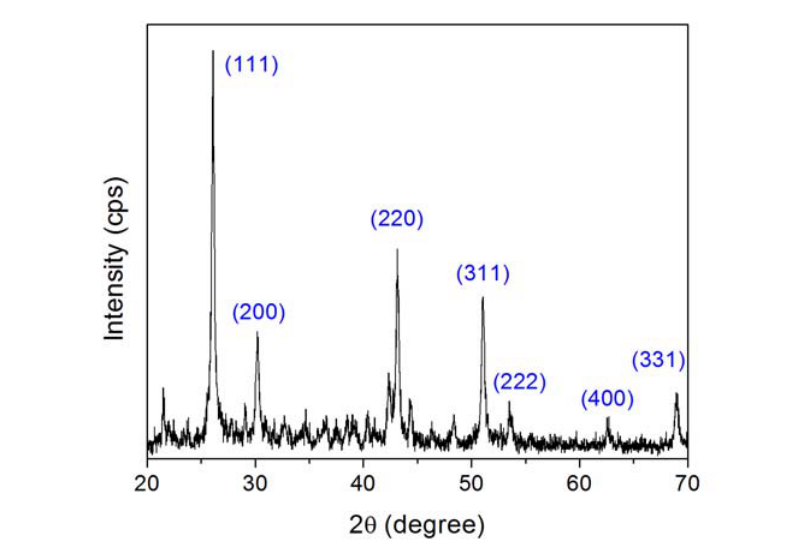
Figure 1. XRD results revealing the structure of PbF JCPDF file 06-0251. Major diffraction peaks corresponding to cubic PbF the numerous weak diffraction peaks are originated from the